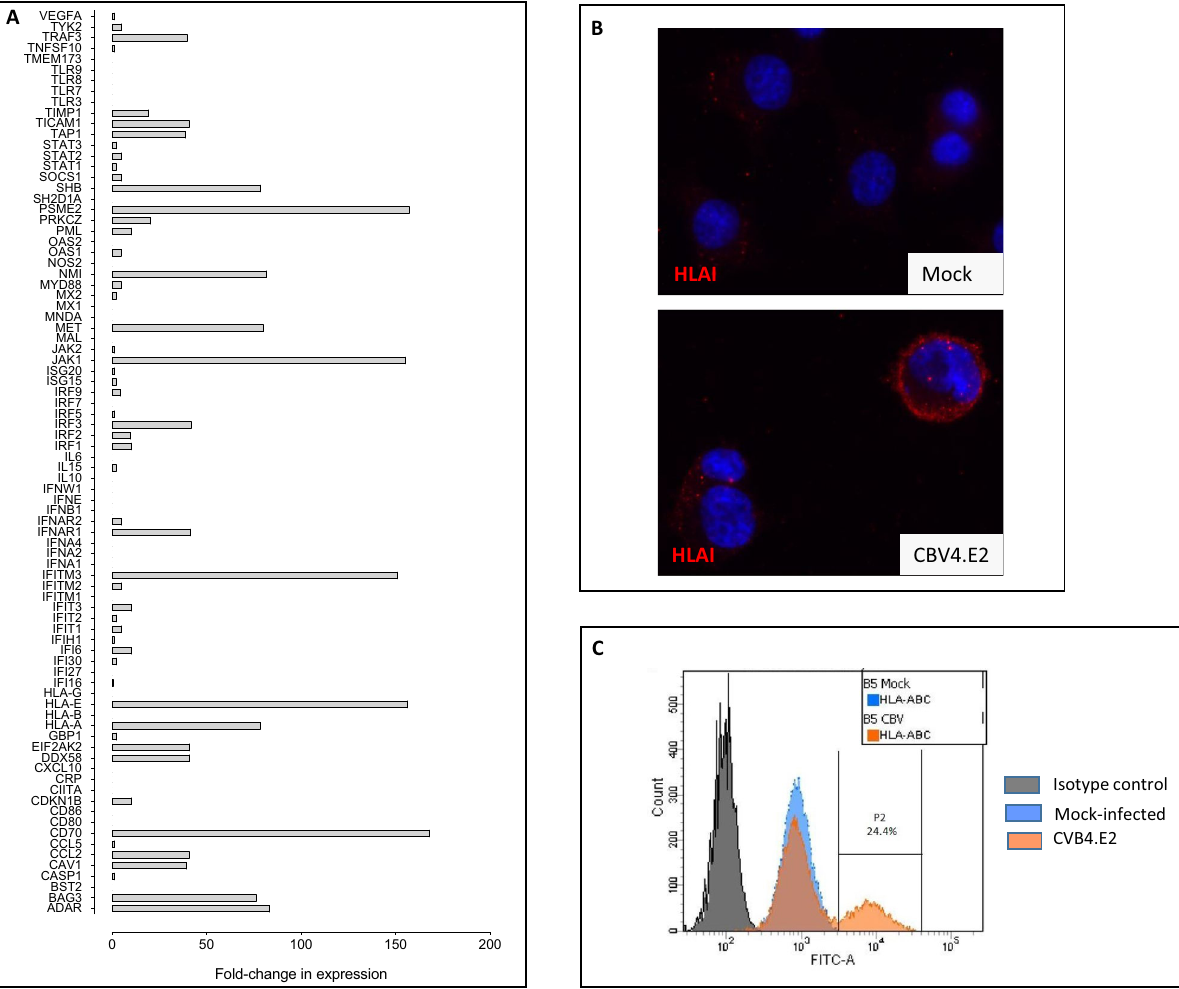
Figure 2. Induction of viral response genes following infection of 1.1B4 cells with Coxsackie B4.E2. ( A ) A human RT2-Profiler Type 1 IFN PCR array was used to monitor the expression of target viral response genes in mock or CBV4.E2 infected 1.1B4 cells harvested on day 44 post infection. ( B ) HLA Class I expression was studied by immunocytochemistry in mock or CVB4.E2-infected 1.1B4 cells harvested on day 71 post-infection. ( C ) Flow cytometry was used to measure cell surface expression of HLA class I on mock (blue) and CVB4.E2 infected (orange) 1.1B4 cells harvested on day 98 post infection. The profile of cells labelled with isotype control antiserum is shown in